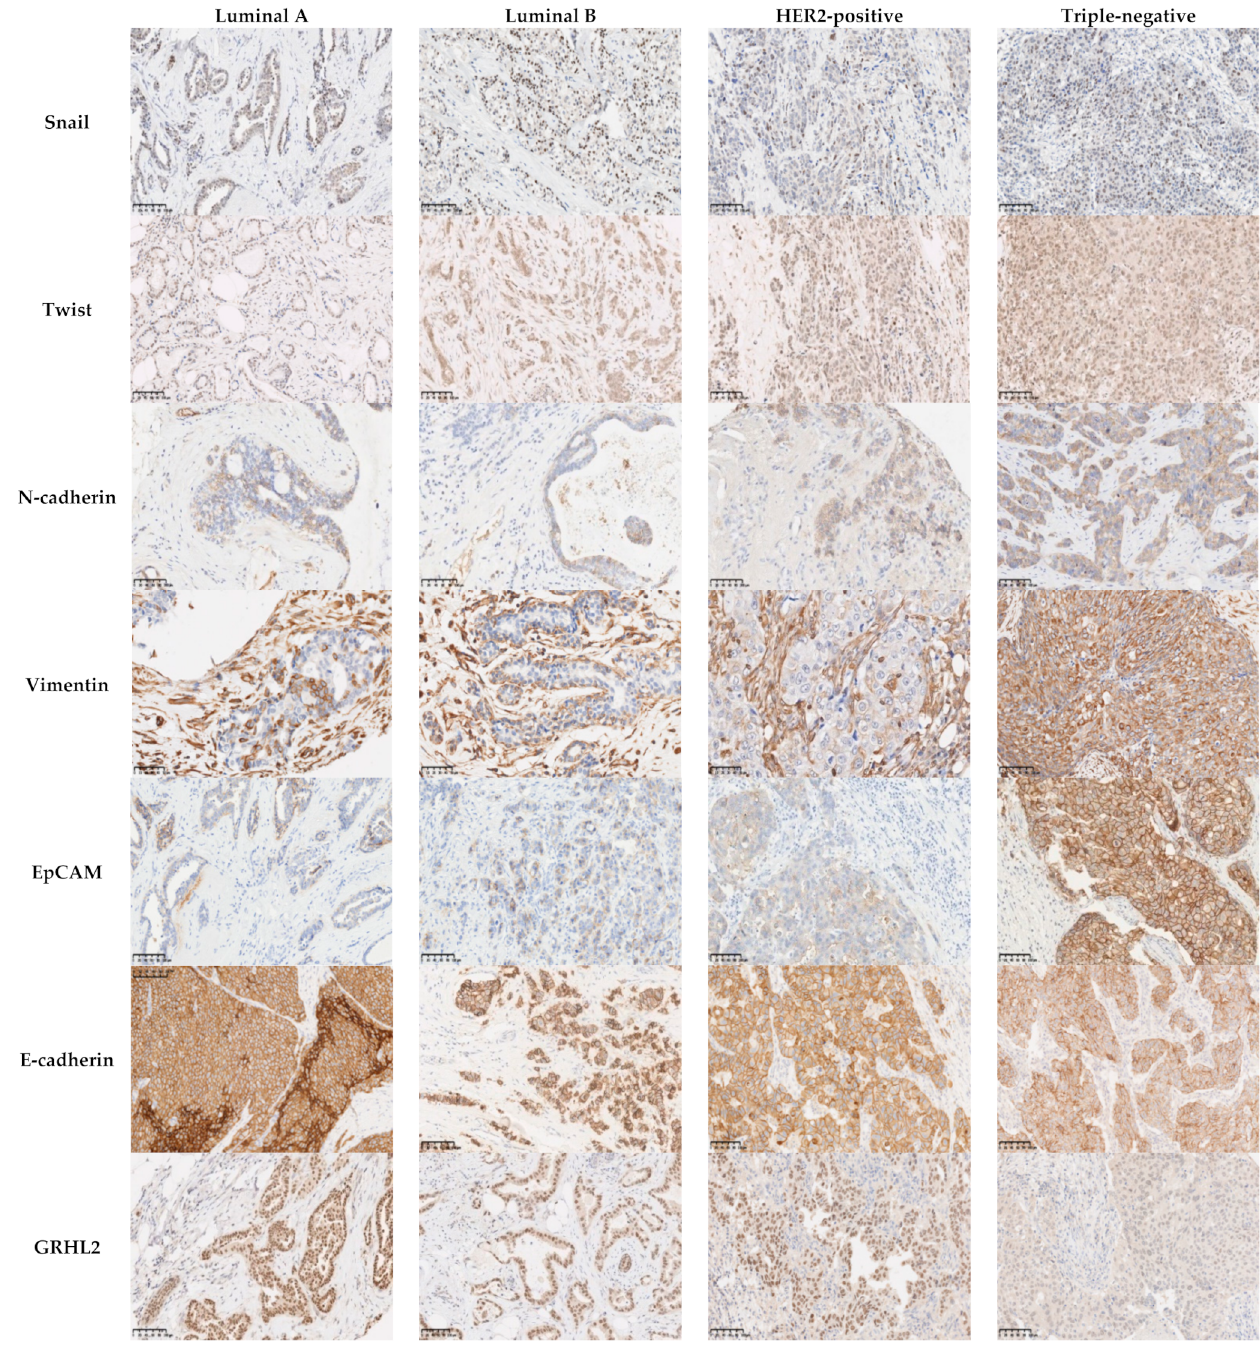
Figure 2. Association between the protein expression of EMT-related markers and breast cancer molecular subtypes. There was no association between the expression of the mesenchymal markers Snail ( p = 0.176) and Twist ( p = 0.617) and the molecular subtypes. The mesenchymal markers N-cadherin and Vimentin and the epithelial marker EpCAM were overexpressed in triple-negative carcinoma ( p = 0.001, p < 0.0001, and p < 0.001, respectively). Areduction in the levels of expression of E-cadherin was more often observed in triple-negative carcinomas (60.5%; p = 0.001), while 81% of the cases with a low or negative expression levels of GRHL2 were triple-negative ( p < 0.001). Scale bars: 100 µ